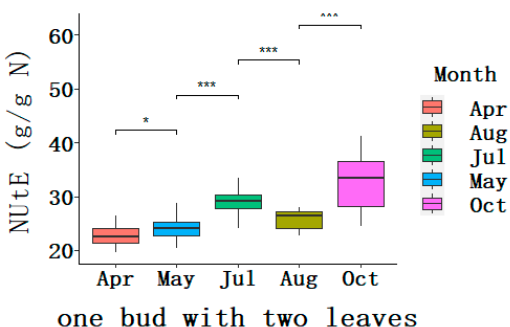
Figure 3. Boxplot for dynamic N utilization e ffi ciency (NUtE, g / g N) for the harvest leaves of the twenty tea plant varieties during the growing seasons. The box represents the interquartile range (IQR), the bisecting line represents the median, and the whiskers represent 1.5 times the IQR. Asterisks indicate significant di ff erences between two consecutive averaged NUtEs, * p < 0.1, *** p < 0.01 ( t -test). Table 2. Summary for NUtE (g / g N) in the part of one bud and two leaves for the twenty tea varieties over all the growing seasons.